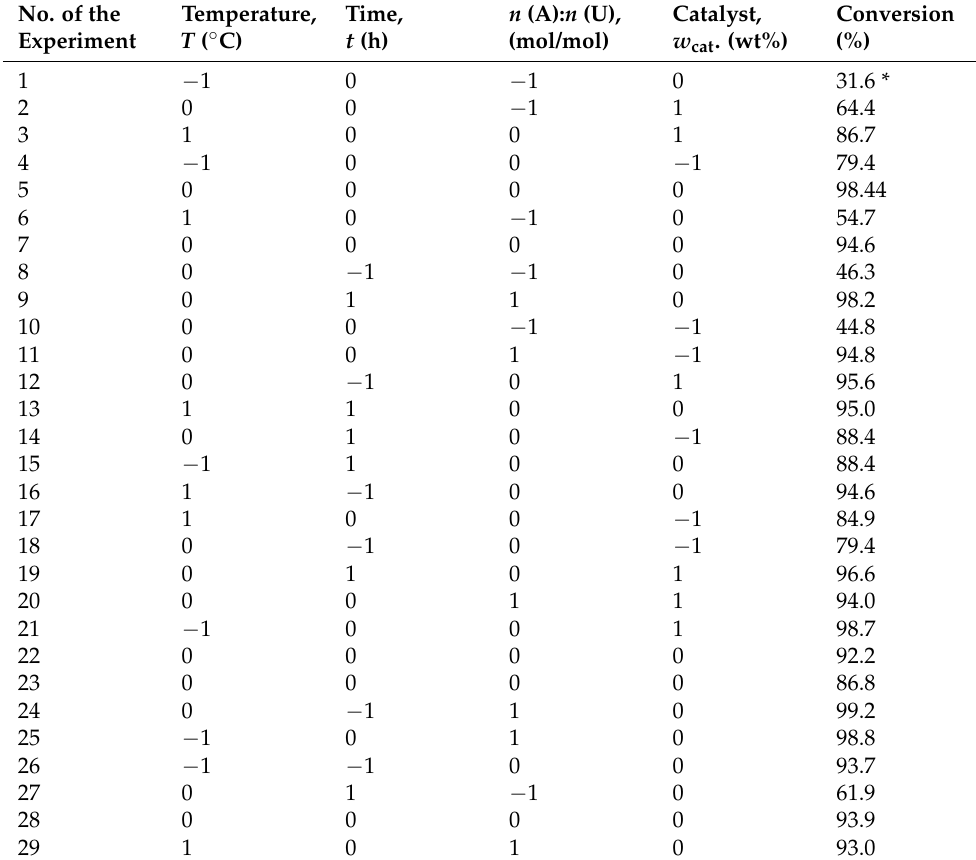
Table 2. Calculated conversions of transesterification reaction with corresponding parameter values. No. of